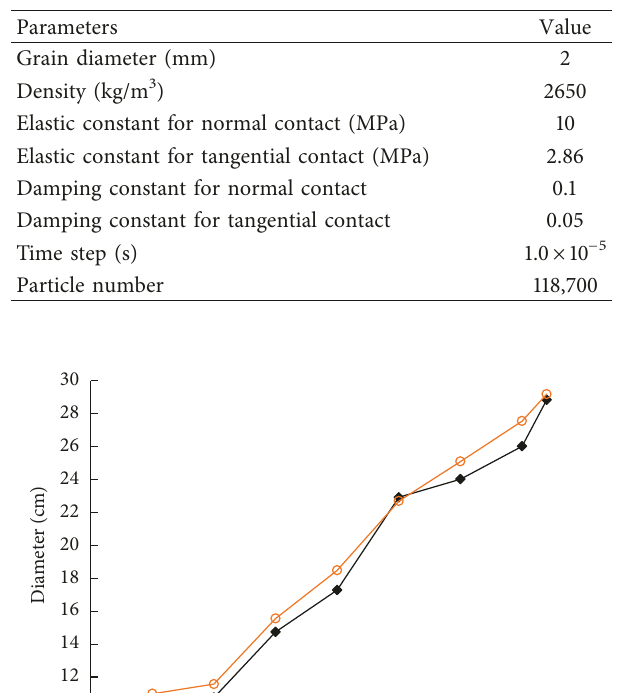
Figure 5: The time-history curve of the cone Table 2: The parameters used in the MD simulation of a sand slump.